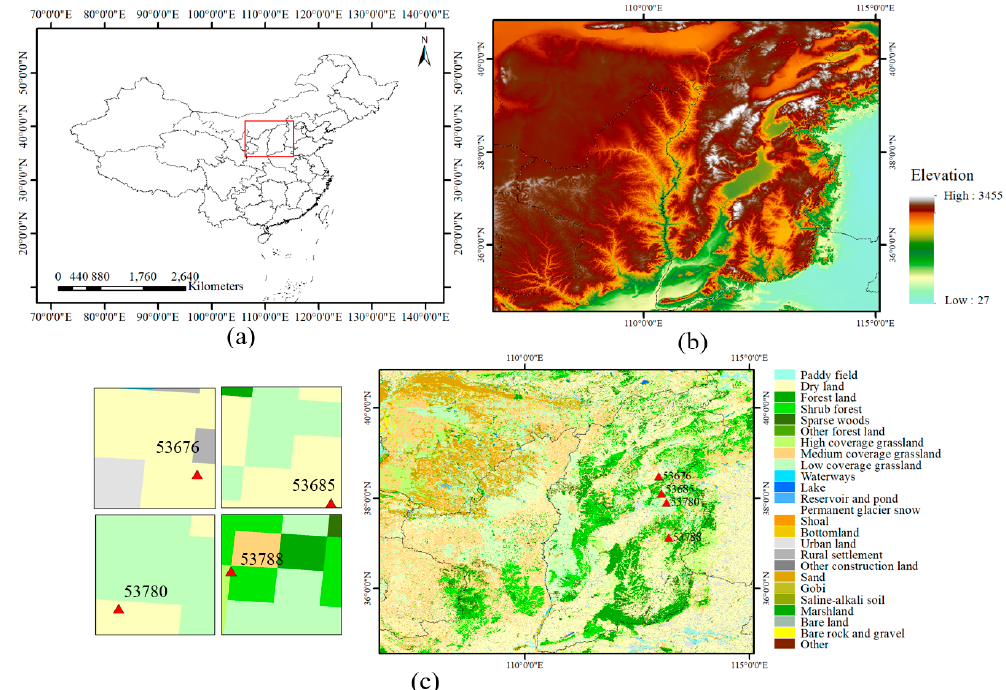
Figure 1. The study area in northern China with the geographical locations of four soil moisture (SM) stations. ( a ) Location of the study area. ( b ) Elevation from the shuttle radar topography mission (SRTM) digital surface model (DSM). ( c ) Land cover map and the 3 km footprints over the four stations: 53676, 53685, 53780, and 53788. Details of the background maps are described in Section 2.1.5.